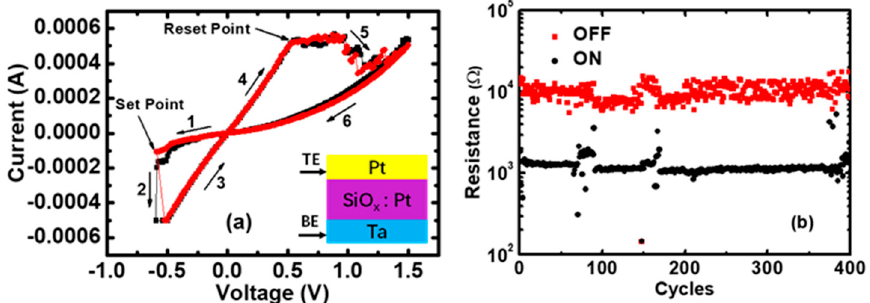
Figure 1. The Current–Voltage (I–V) characteristics in Pt/Pt:SiO x /Ta memristors. ( a ) The I–V curves for the Set and Reset transitions. A current compliance limit of 0.5 mA is given in the Set process to avoid the breakdown; ( b ) The ON and OFF resistance states in 400 cycles, extracted at low voltage (0.1 V).